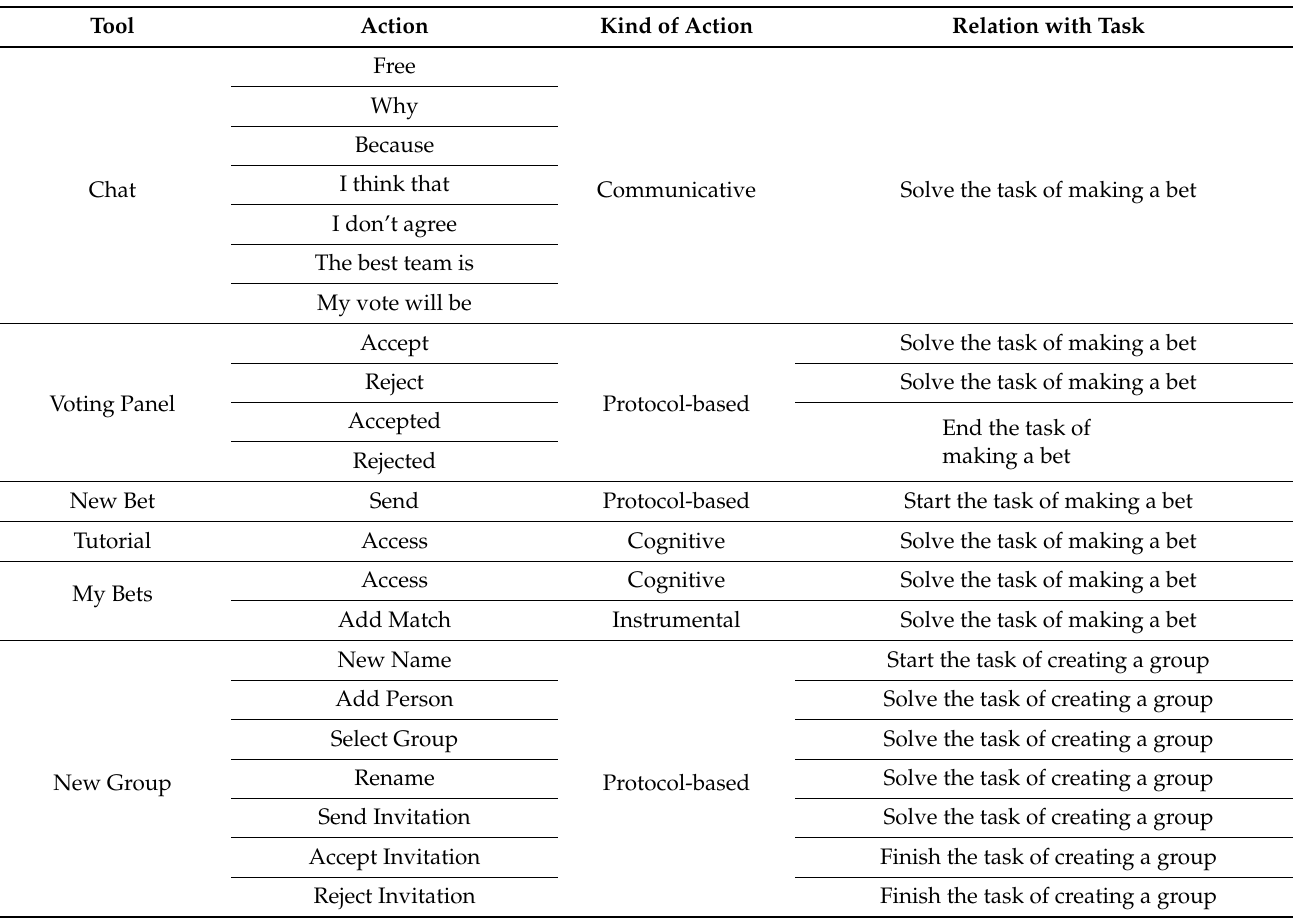
Table 2. Task model.